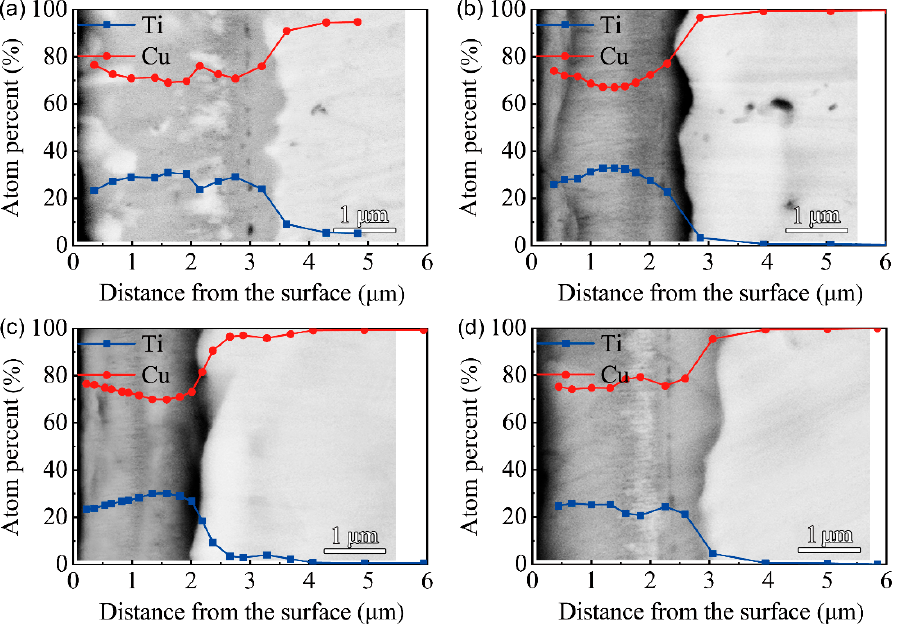
Figure 6. BSEM images of the cross-section and EDS results of F3 film on C17200 Cu alloy after thermal diffusion: ( a ) 650 °C for 1 h; ( b ) 650 °C for 4 h; ( c ) 750 °C for 1 h; ( d ) 750 °C for 4